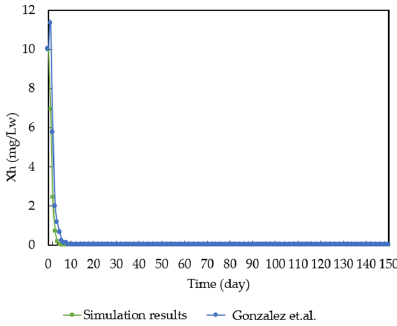
Figure 5. The behavior of (X h ) validation [24].